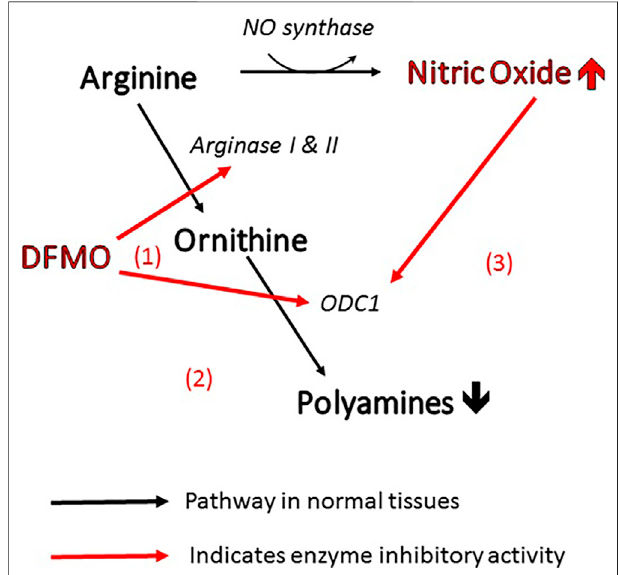
FIGURE 1 | Three ways in which DFMO acts to reduce polyamines and increase NO. All of these changes inhibit viral infectivity.